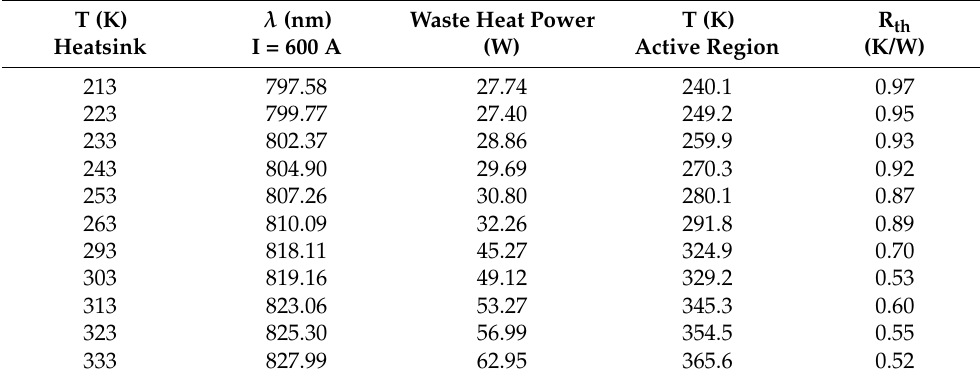
Table 4. The temperature of the active region at different operating